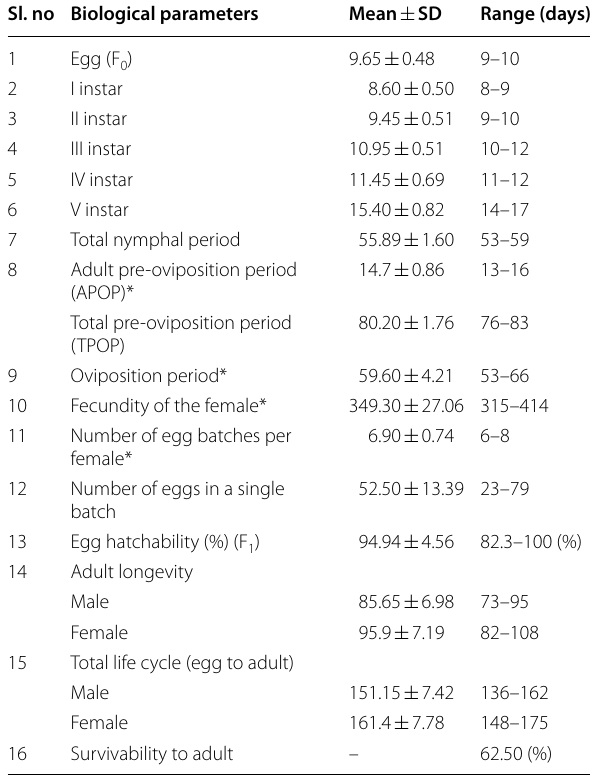
Table 1 Biological parameters of reduviid bug, Rhynocoris marginatus on fall armyworm, Spodoptera frugiperda